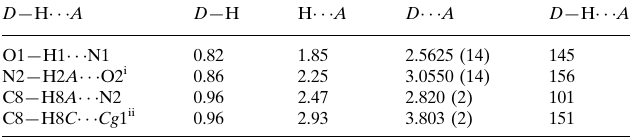
Hydrogen-bond geometry (A˚ , (cid:1)